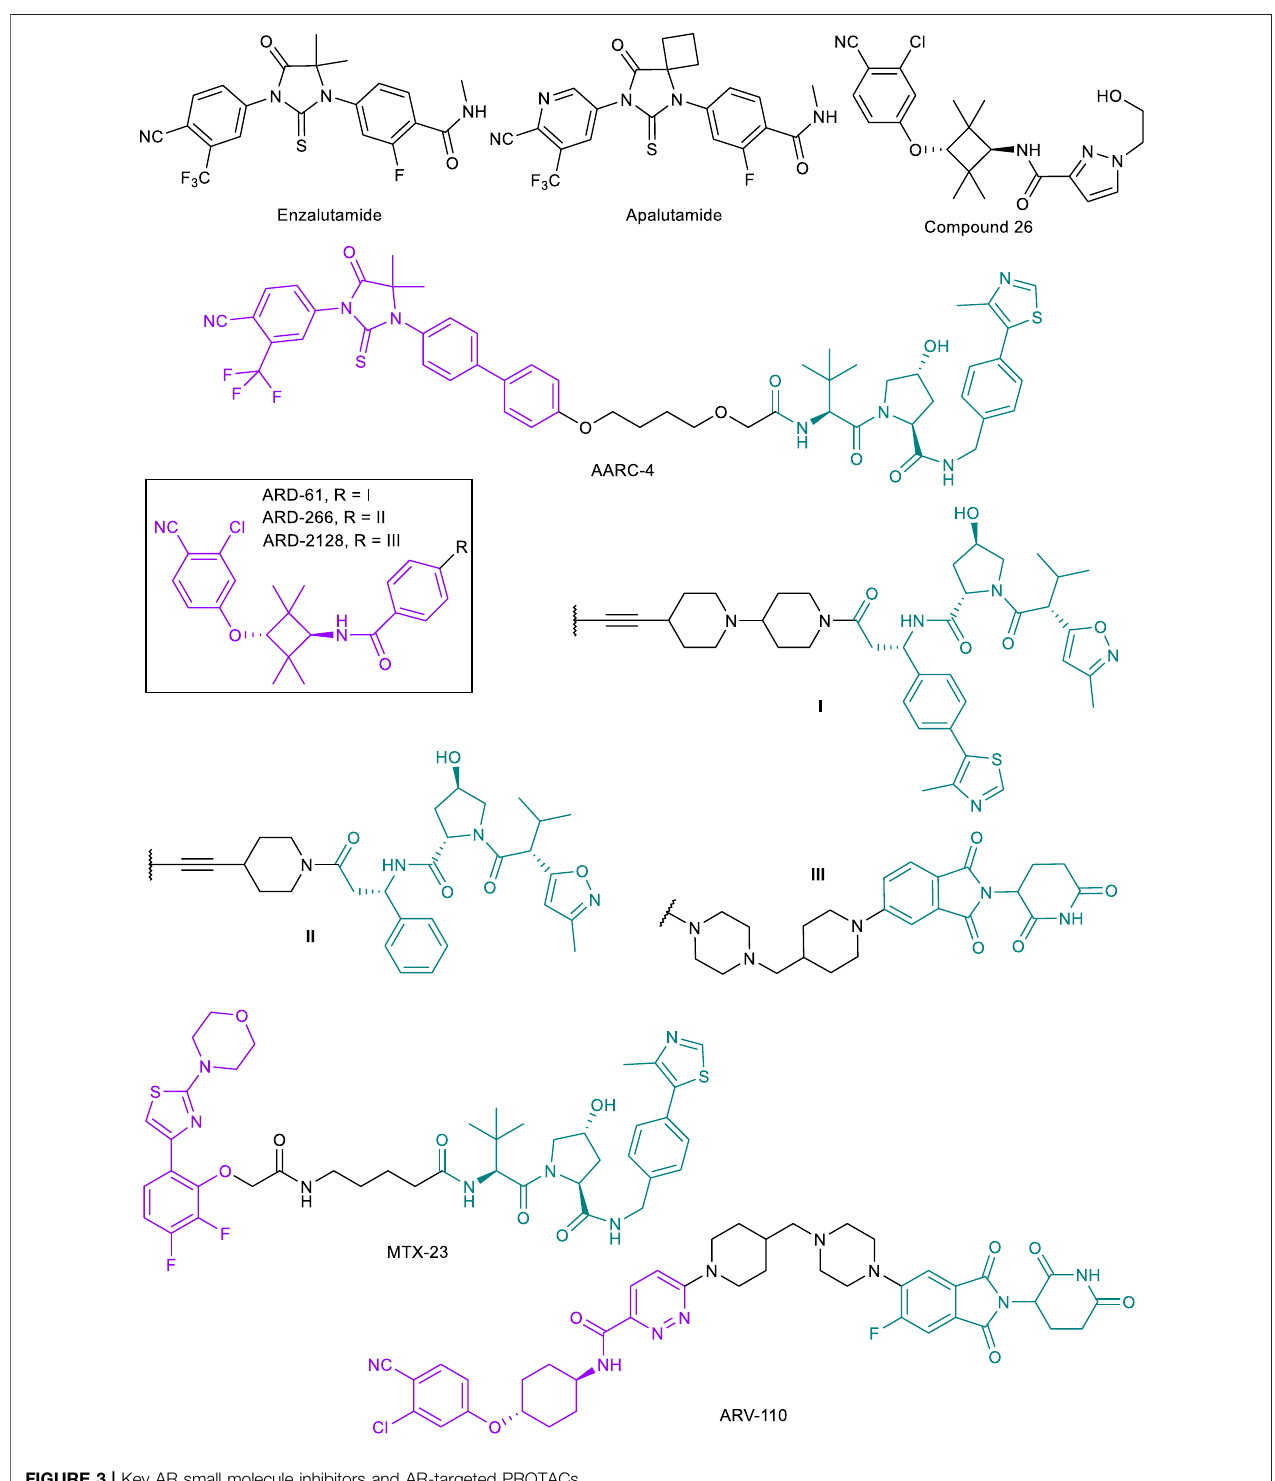
FIGURE 3 | Key AR small molecule inhibitors and AR-targeted PROTACs.